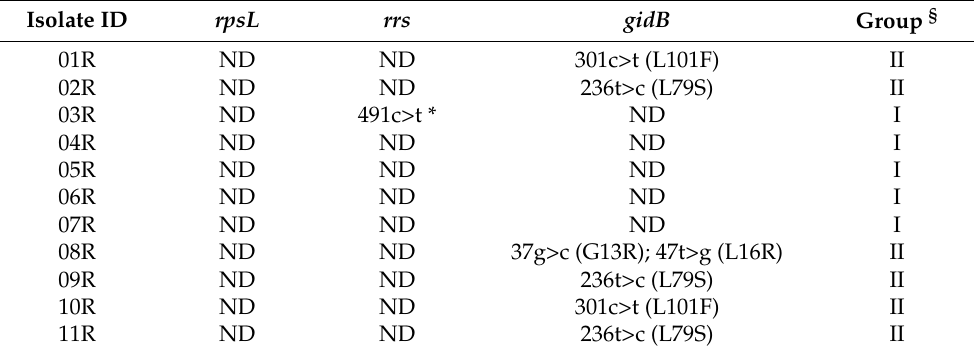
Table 1. Overall results of the molecular analysis of rpsL , rrs and gidB genes from 11 clinical isolates of M. tuberculosis showing resistance to